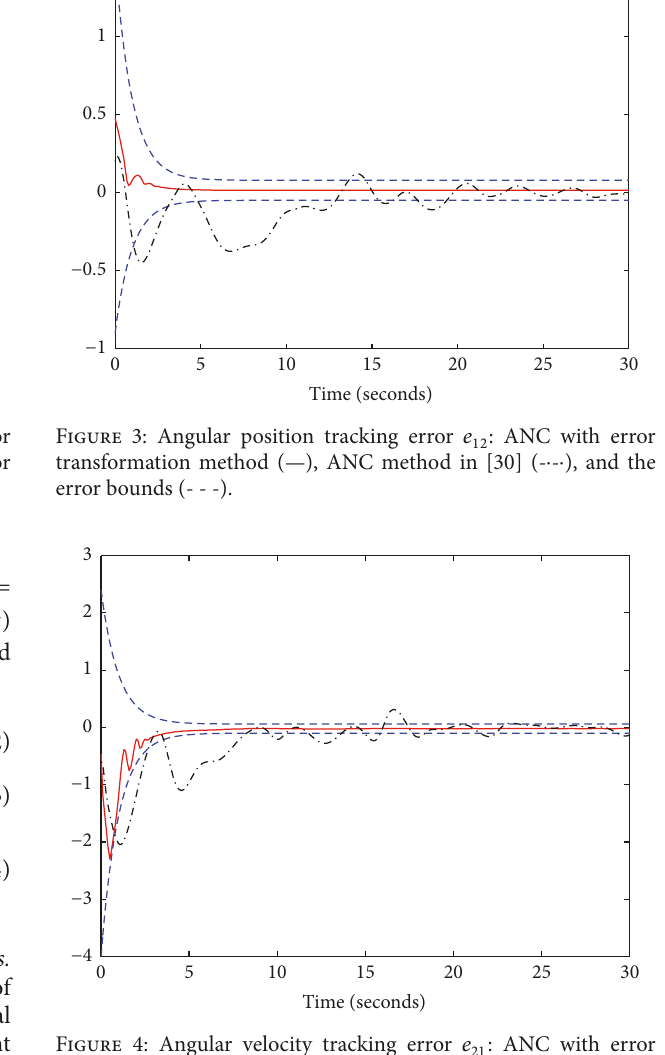
Figure 4: Angular velocity tracking error 𝑒 21 : ANC with error transformation method (—), ANC in [30] (- ⋅ - ⋅ ), and the error bounds (- -